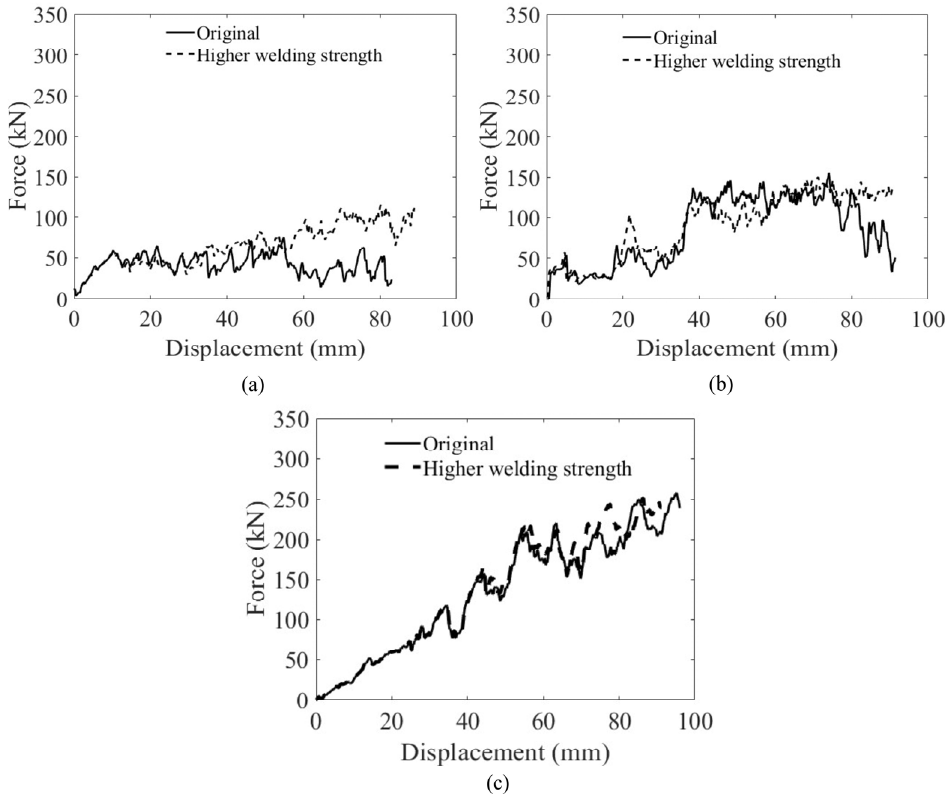
Figure 10. FE model simulated force-displacement responses with original and increased welding strength: ( a ) Case 1; ( b ) Case 2; and ( c ) Case